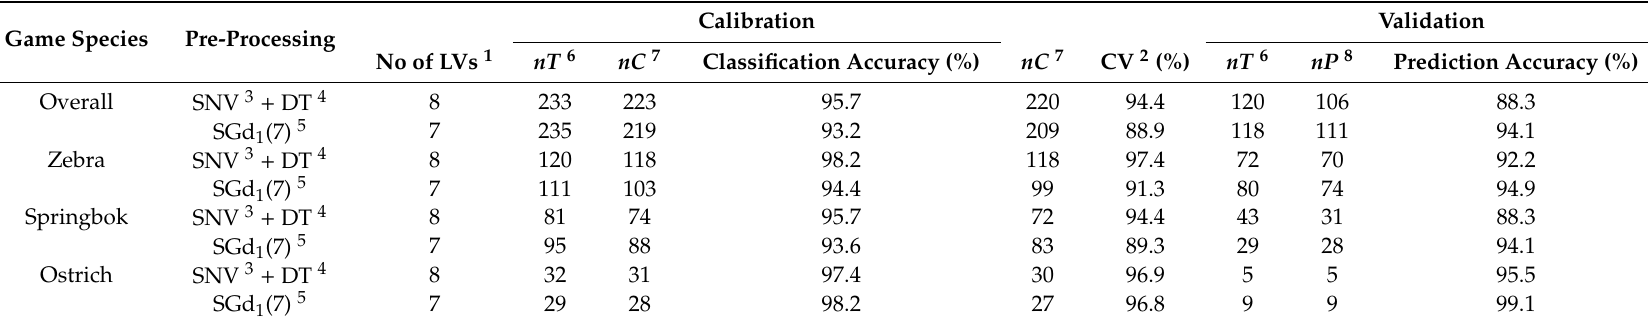
Table 1. An overview of the accuracies of the partial least squares discriminant analysis (PLS-DA) models with standard normal variate (SNV) + detrend and Savitzky–Golay (first-derivative, second-order polynomial, seven points) pre-processing applied to distinguish between